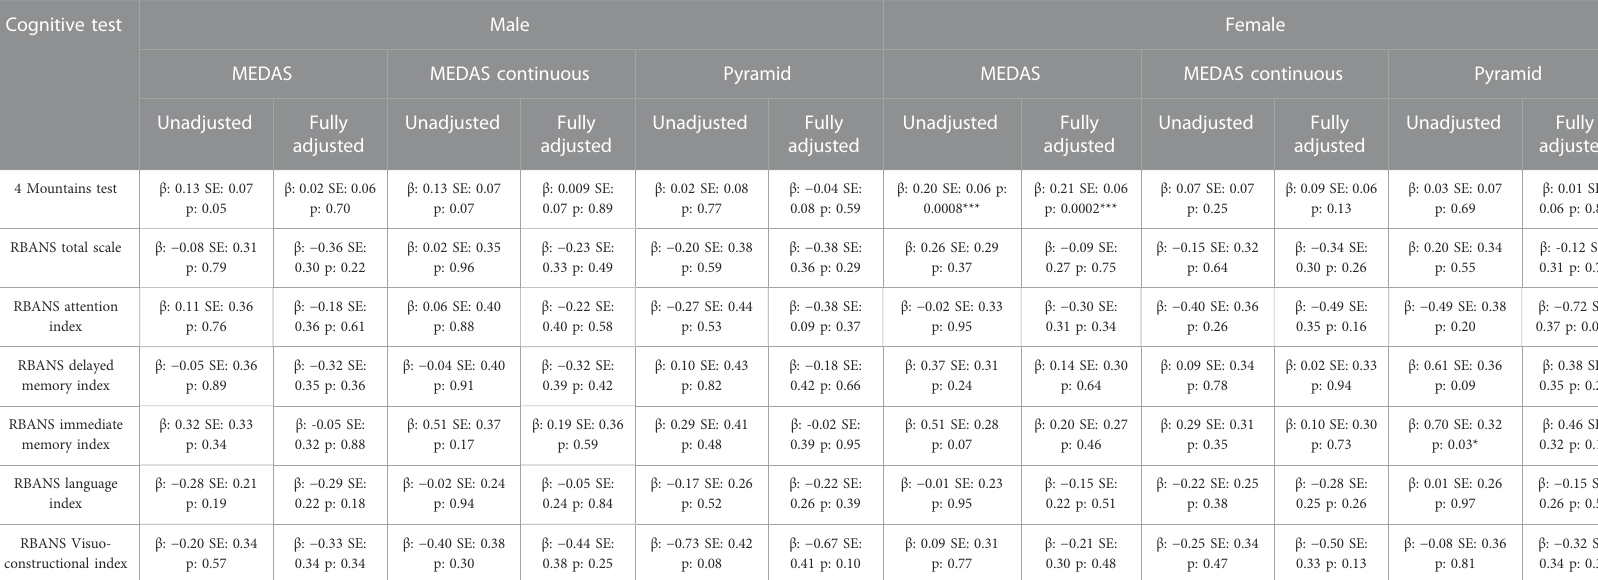
TABLE 5 Linear regression models of MedDiet scores (MEDAS, MEDAS Continuous and Pyramid) with cognitive outcomes living in male and female participants. Unadjusted Model: MedDiet Score; Fully Adjusted Model:MedDiet Score, age,education, family history, APOE,physicalactivity, smoking,sleep, BMI,hypertension, hypercholesterolemia,hyperglycaemia, diabetes, stroke, antihypertensive medication use,diabetic